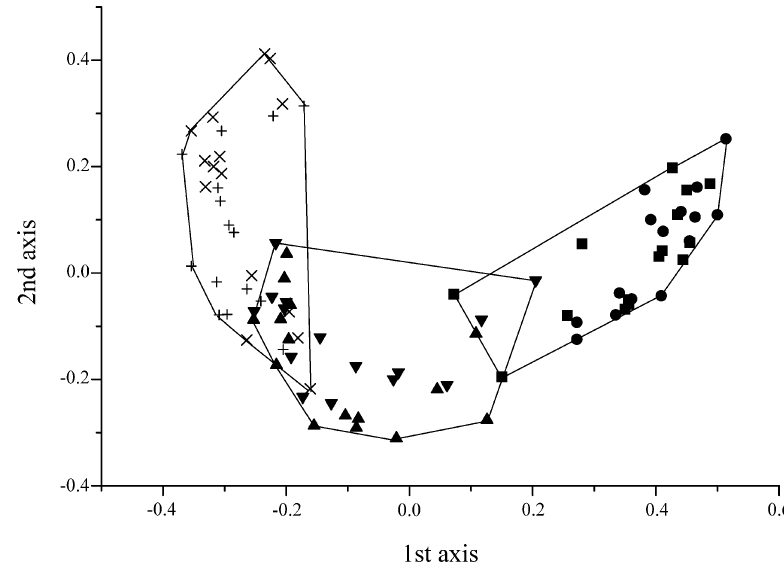
Fig. 2. Ordination (PCoA by Bray- Curtis dissimilarity) of the pitfall catches within the habitats. +: